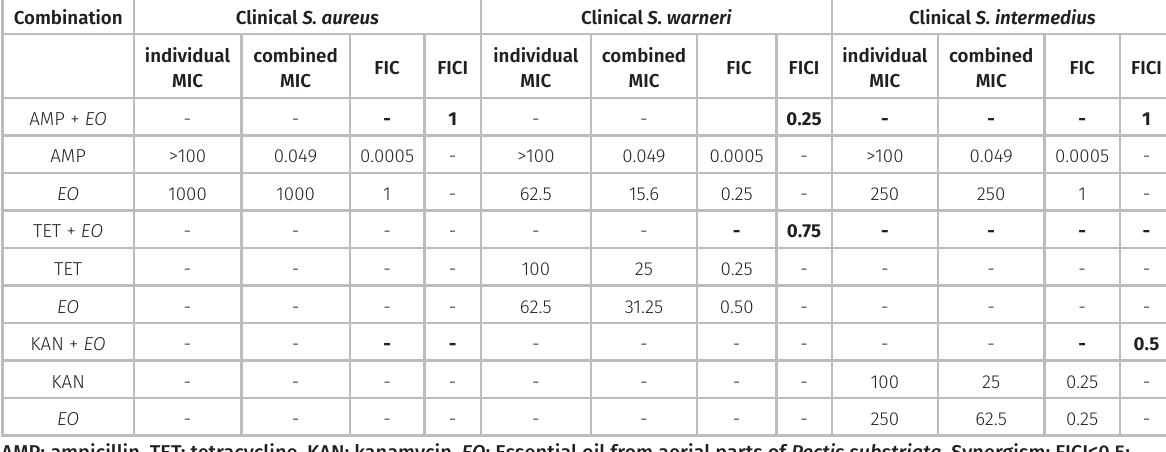
Table I. Minimum inhibitory concentration (MIC, in µg.mL -1 ) of antibiotics and Pectis substriata essential oil, fractional inhibitory concentration (FIC) and fractional inhibitory concentration index (FICI), of antibiotics- essential oil pairs, against drug-resistant